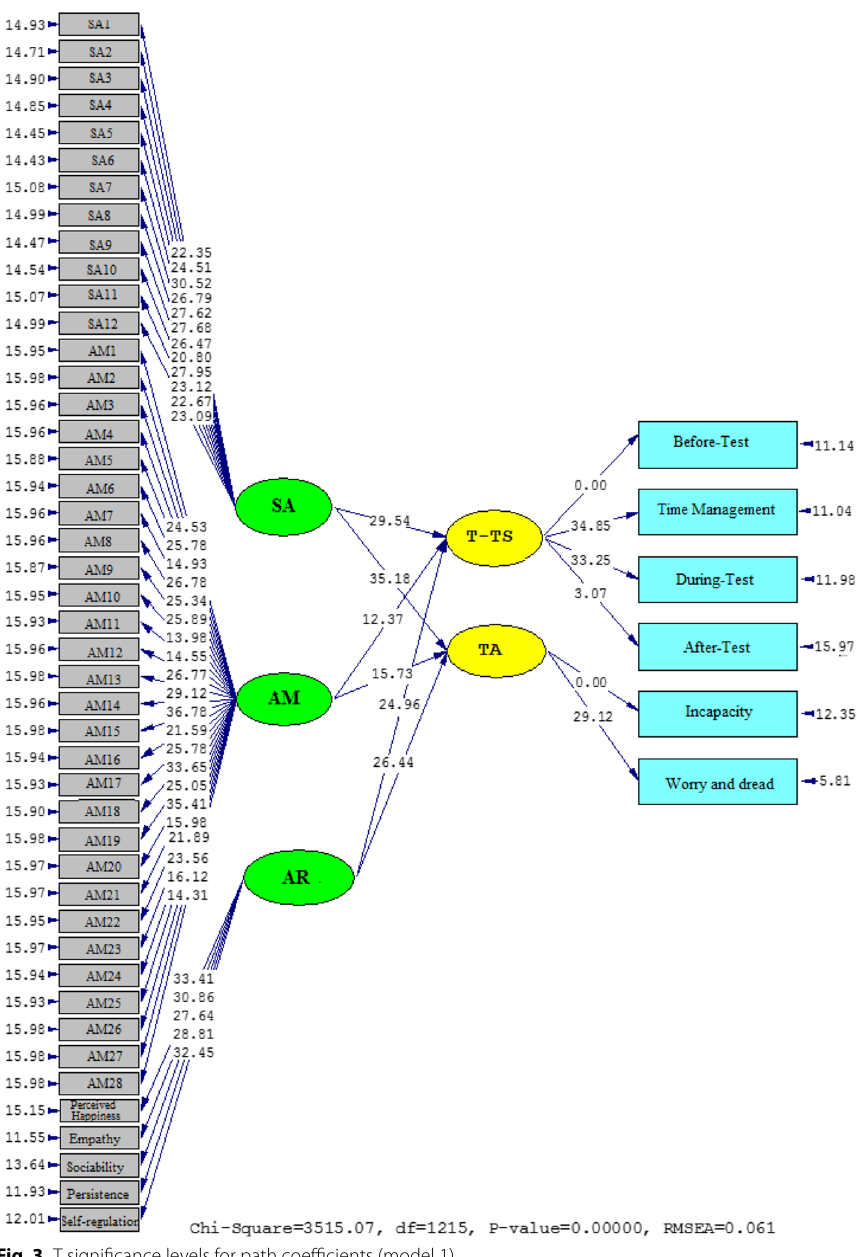
Fig. 3 T significance levels for path coefficients (model